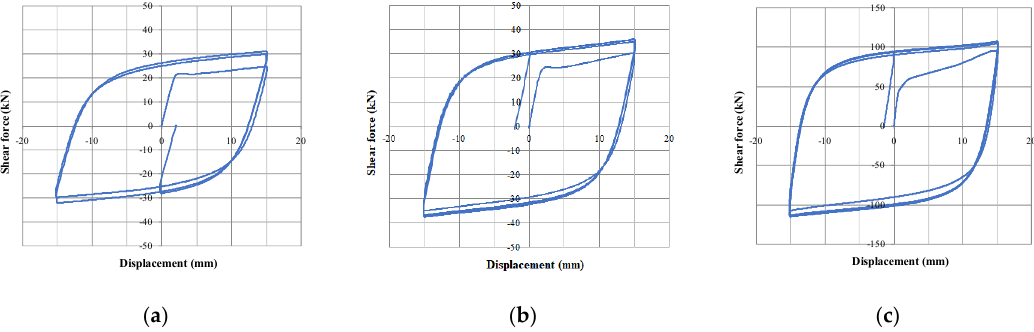
Figure 4. Shear force versus displacement curve of tested specimens: ( a ) SD1; ( b ) SD2; ( c ) SD3.